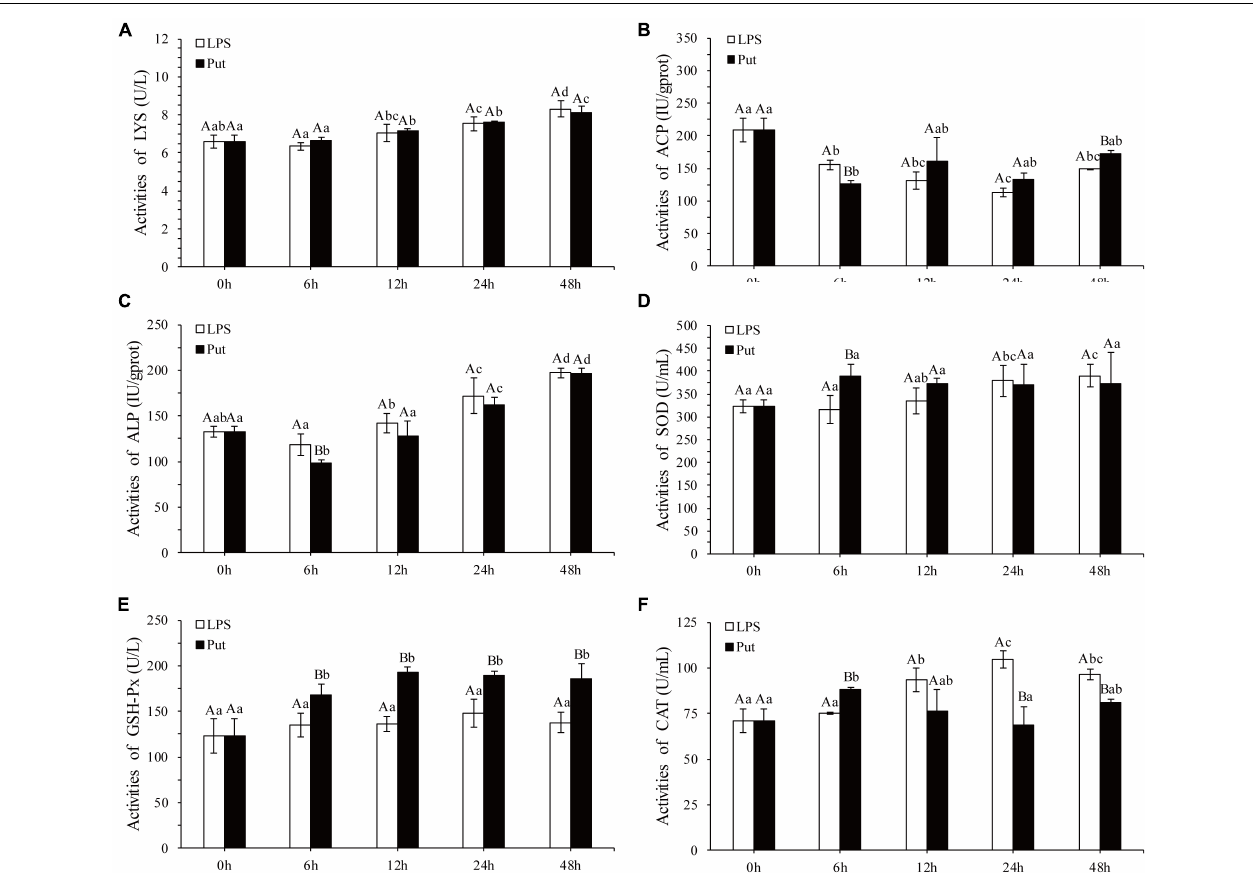
FIGURE 2 | Detection of enzyme activity after the putrescine treatment. LYS, lysozyme; ACP, acid phosphatase; ALP, alkaline phosphatase; SOD, superoxide dismutase; GSH-Px, glutathione peroxidase; CAT, catalase. Values are shown as mean ± SE ( N = 5). Lowercase letters represent differences at different time points in the same groups, and capital letters represent differences in the different groups at same time points. Lipopolysaccharide (LPS) group, PBS_LPS; Put group, Put dihydrochloride_LPS. (A–F) represent the activities of LYS/ACP/ALP/SOD/GSH-Px/CAT after the putrescine treatment, respectively.